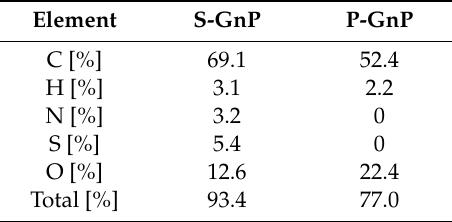
Table 1. Results of elemental analyses for sulfonic acid-functionalized graphene nanoplatelets